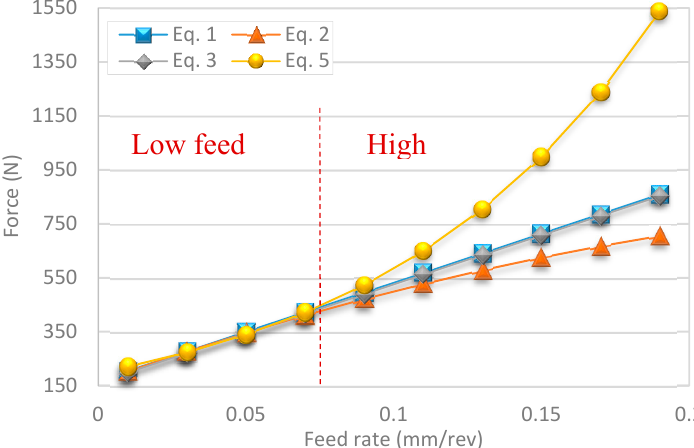
ff ect of change in feed rate on cutting